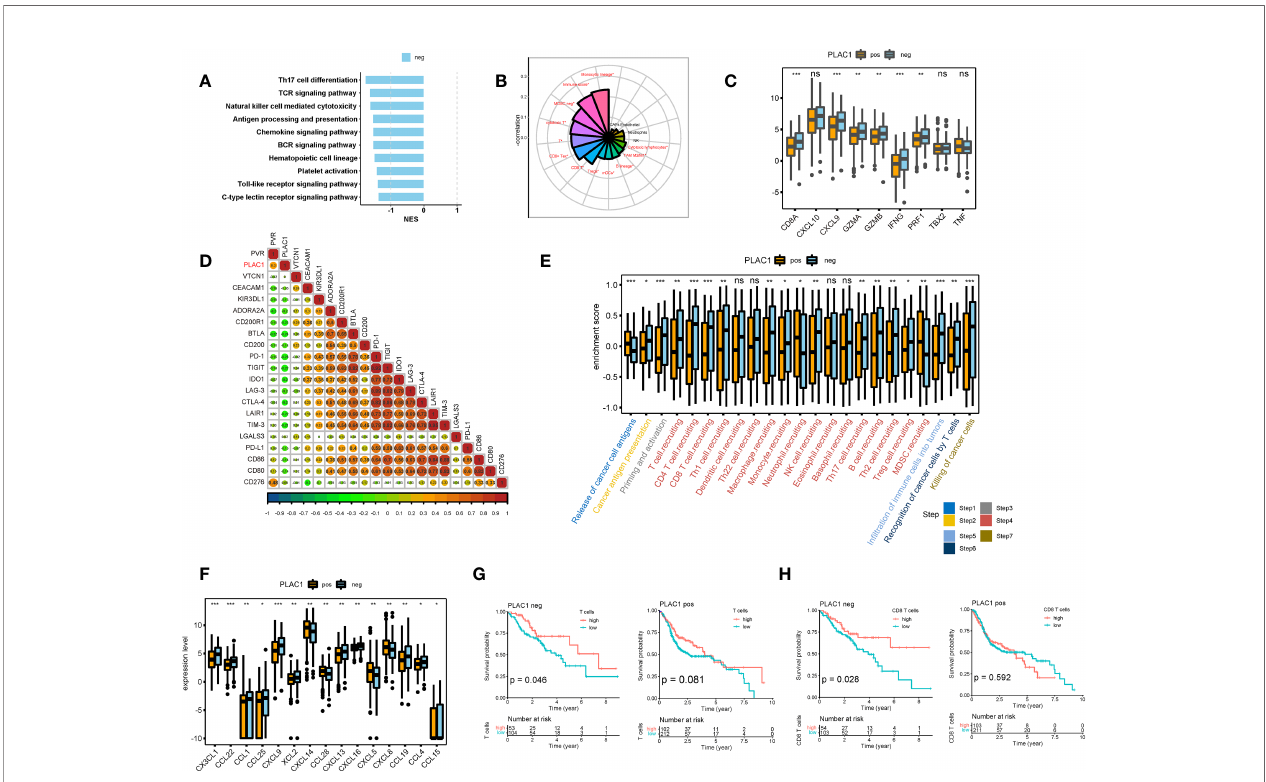
FIGURE 3 | Plac1 was negatively related to the immune activities in head and neck squamous cell carcinoma. (A) Gene Set Enrichment Analysis of immune- related hallmarks in differentially expressed genes between plac1-positive and plac1-negative samples. (B) Correlations between plac1 and immune in fi ltration level. (C – F) Differences in the enrichment score or expression level of immune activity-related genes (C) , immune checkpoints (D) , immune cycles (E) , and chemokines (F) in plac1-positive and plac1-negative samples. (G, H) Correlations between T cell (G) and CD8 + T cell (H) level and patient survival in plac1- positive and plac1-negative samples. * p < 0.05, ** p < 0.01, *** p <